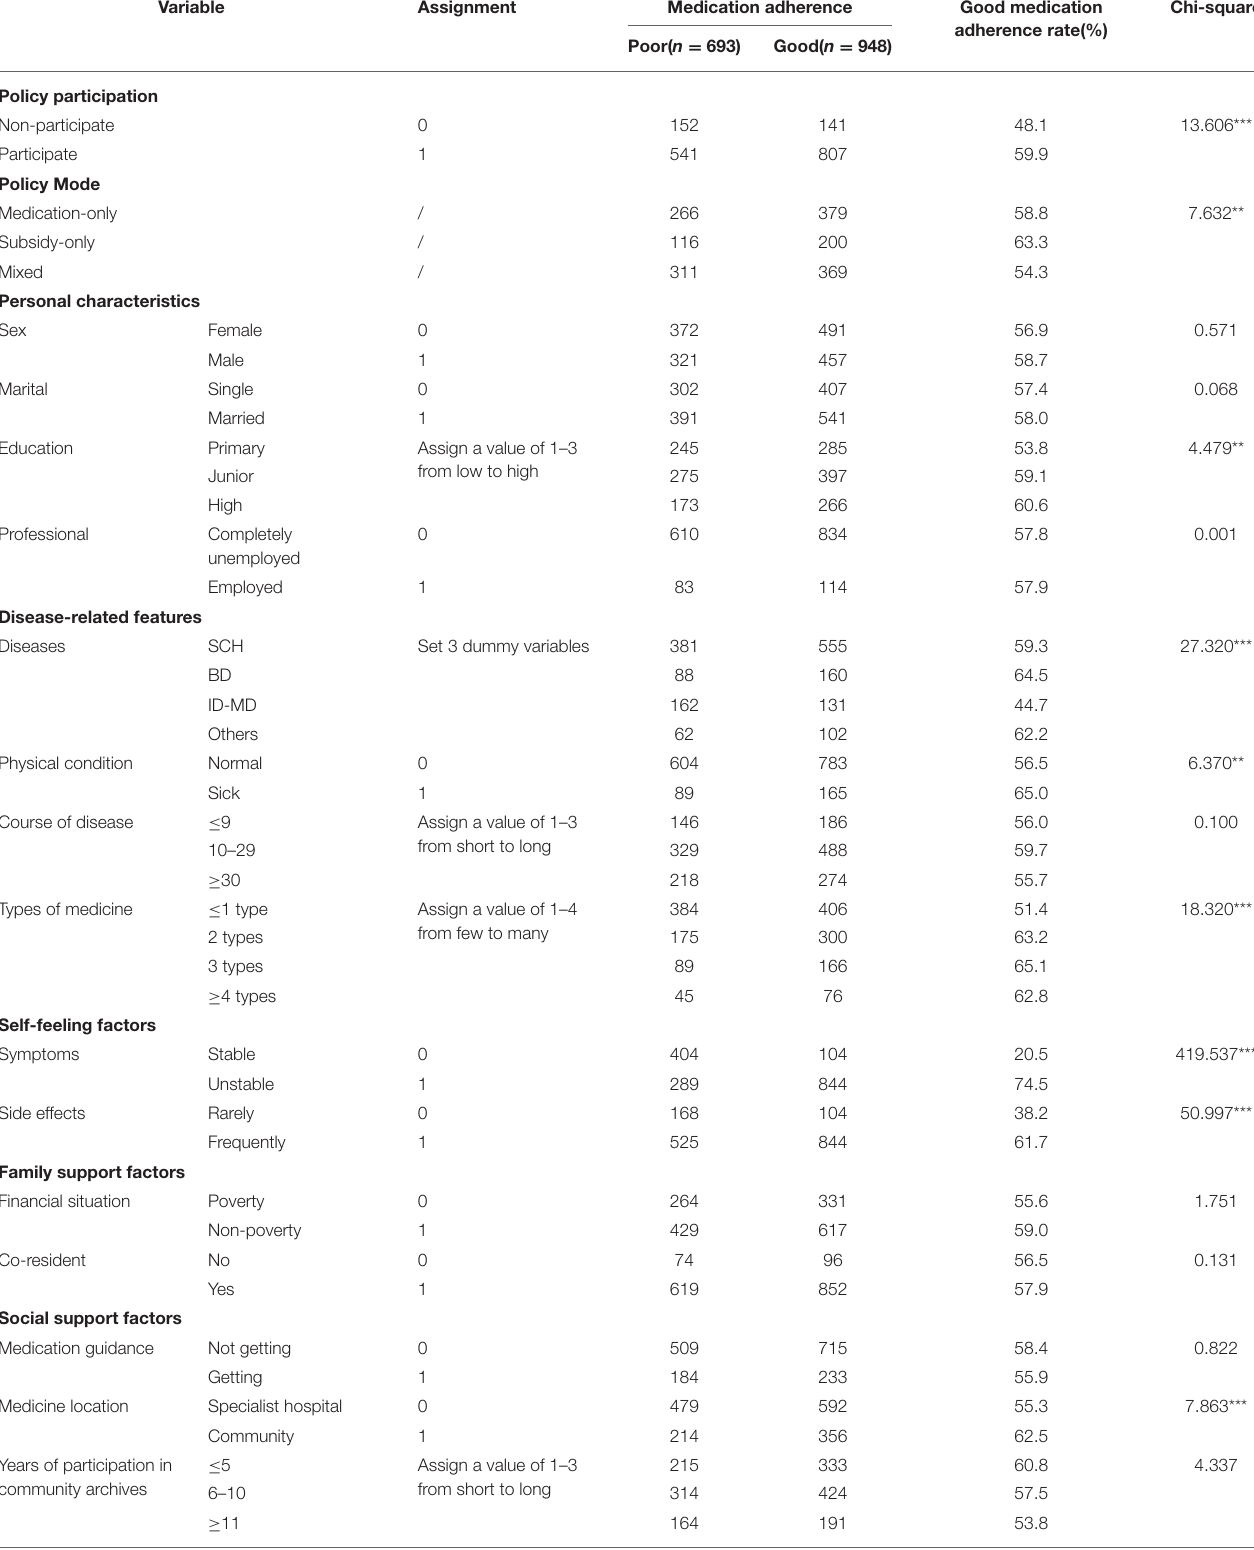
TABLE 2 | Variables assignments and univariate analysis results. Variable